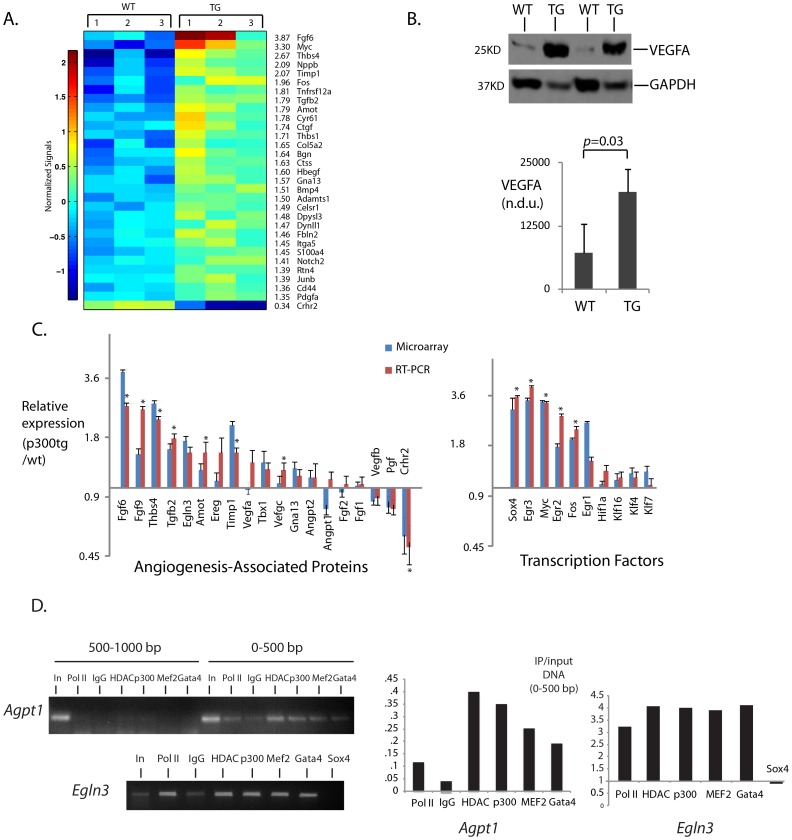
p300 activates an angiogenic transcriptional program.
A. Heatmap. 23 differentially expressed angiogenic genes identified by genome-wide transcription analysis of left ventricular muscle from p300tg and wt littermates at 1 month. Shown are transcript profiles from each of 3 animals per genotype, cutoff > = 1.4 fold, p<0.02). Colorbar represents normalized intensities. Shown to the right of the heatmap are the relative changes of transgenic to wild type. B.
Comparative VEGFA protein levels in p300tg and wt littermate mice at 3 months. (Above) Representative Western blot. Below, quantitation of 3–4 separate determinations per group. C. qPCR validation of microarray-identified genes. N = 3 animals per genotype. *p<0.05. D. Binding of p300 to enhancers in Angpt1 and Egln3 genes. Myocardium from 1 month-old C57Bl/6 mice was subjected to ChIP analysis using the antibodies shown. HDAC = HDAC-9. Pol II = RNA polymerase II. Data were obtained from 6–12 pooled left ventricles per condition.